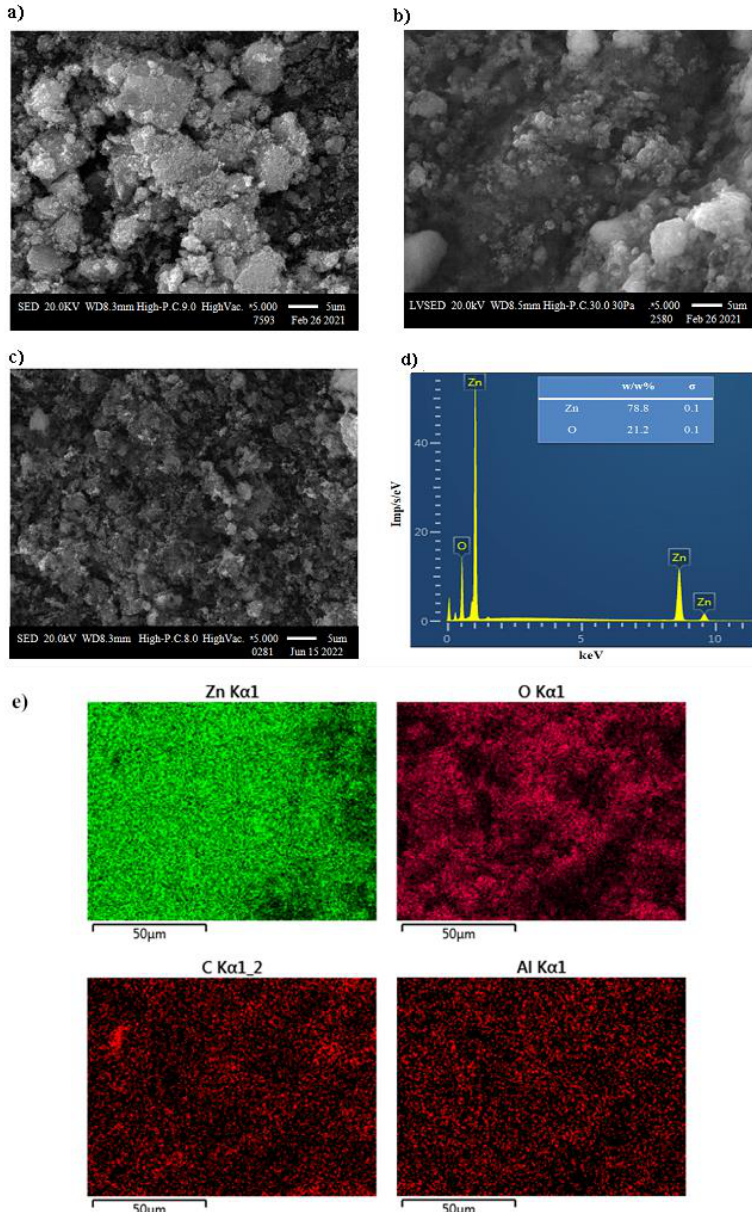
Figure 1. SEM images of ZnO NPs ( a ), ZnO NPs – PEG ( b ), ZnO NPs – Xym ( c ), EDX analysis of ZnO NPs – Xym ( d , e ). Analysis was carried out on aluminum foil. Table 2. Comparison of FTIR spectra data for studied